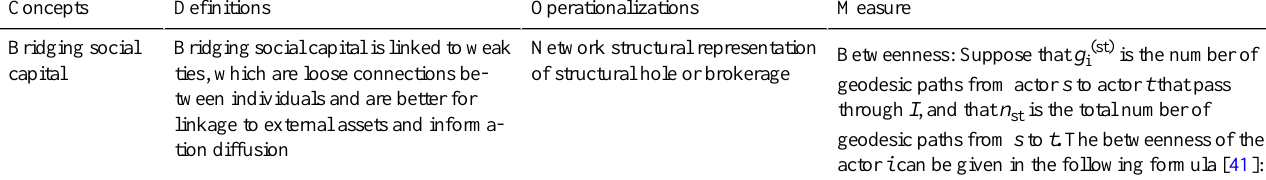
Table 1. Definitions, operationalizations, and measurements of the key theoretical